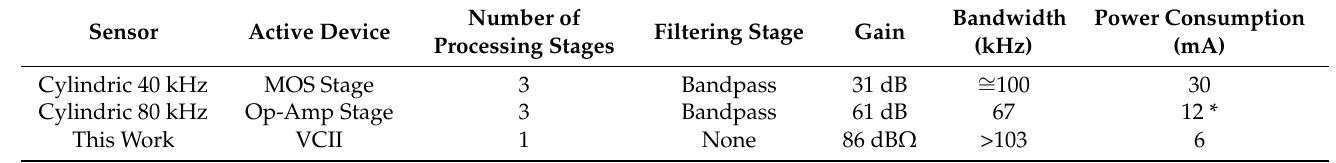
Table 2. Performance of the proposed VCII-based electronic interface compared to other commercially available. Sensor Active